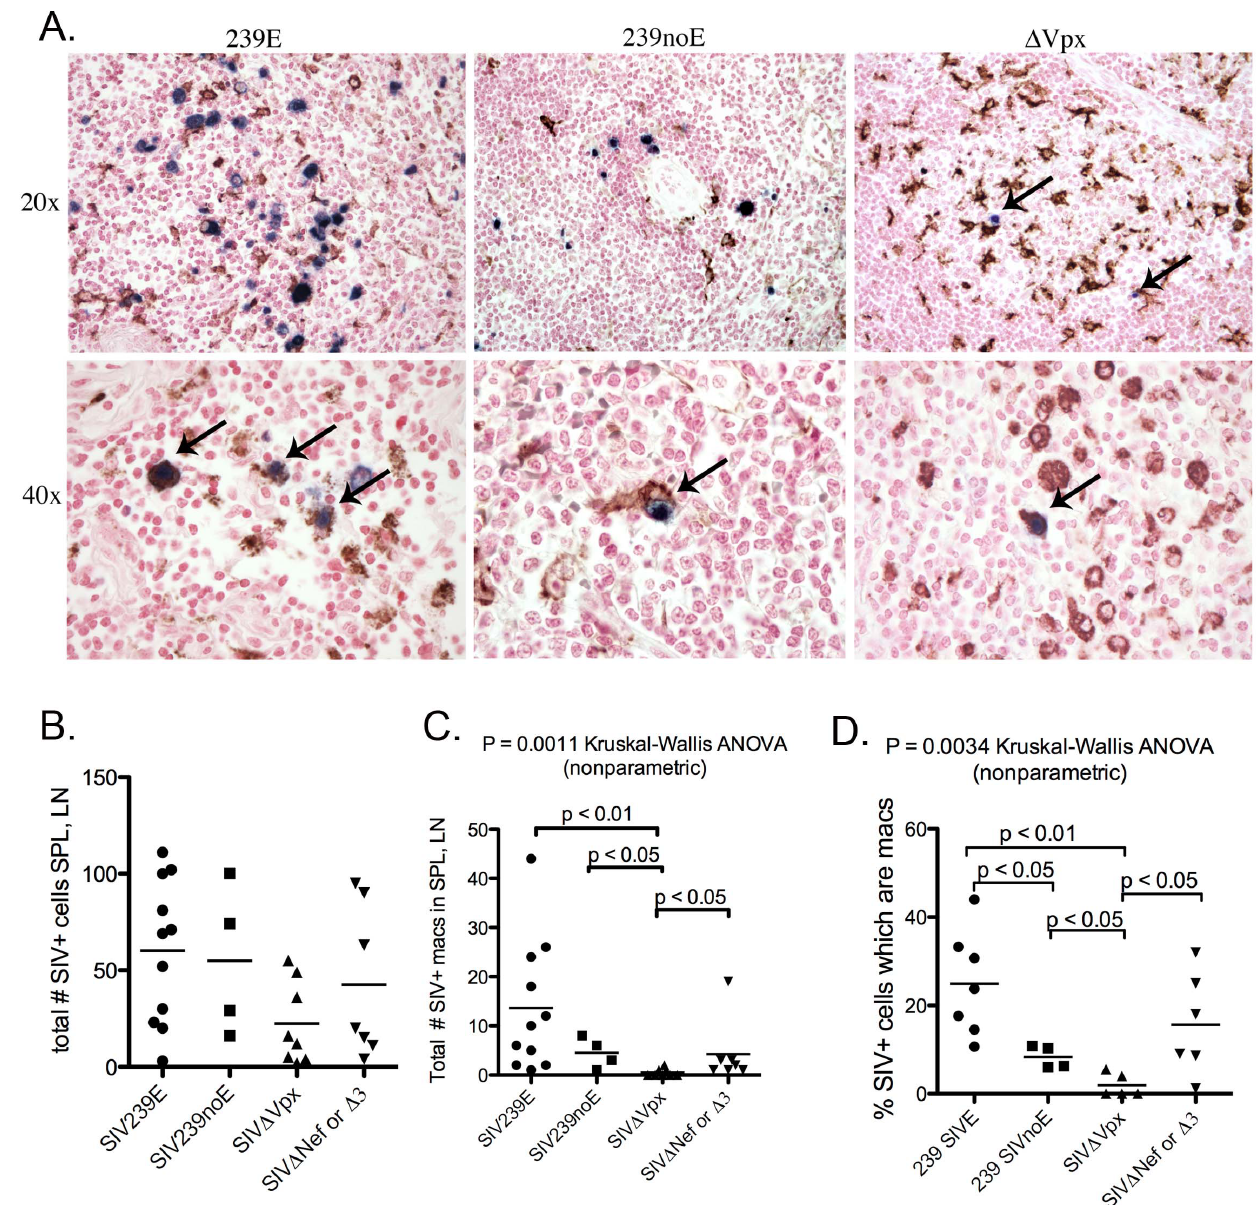
Figure 4. Double-label immunohistochemistry and insitu hybridization of lymphoid tissues. (A) Representative images of SIV in situ hybridization (ISH, blue) with double-label immunohistochemistry for monocyte/macrophage lineage cell marker Ham56 (DAB, brown) in rhesus macaques in groups SIV239E (left), SIV239noE (middle), and SIV D vpx (right). The top images of lymphoid follicles depict Ham-56 + cells morphologically consistent with follicular DCs. Images in the second row depict HAM56 + cells in the red pulp of the spleen (left and center) or paracortex in lymph node (right). Frequent SIV + HAM56 + macrophages/DCs (M w ) were observed in tissues from the SIV239E and SIV239noE groups, while only rare SIV + Ham56 + macrophages/DCs were observed in lymph node from a SIV D vpx -infected rhesus (arrow). (B). The overall numbers of infected cells in the spleen and lymph node from the 4 groups of animals were not significantly different. (C) However, there were significantly fewer SIV + M w in SIV D vpx monkeys (mean 0.5 SIV + M w ) compared to the SIV239E (mean 13.64 SIV + M w ), SIV239noE (mean 4.5 SIV + M w ) and SIV D nef /SIV D 3 monkeys (mean 6.25 SIV + M w ). (D) SIV infected macrophages made up a much lower percentage of all SIV + cells in SPL and LN of SIV D vpx -infected rhesus (mean 2.2%) compared to SIV239E (mean 22.7%), SIV239noE (mean 8.3%), and SIV D nef /SIV D 3 monkeys (10.1%) (p , 0.05). doi:10.1371/journal.pone.0084463.g004 tissue virus burden in SPL/LN and colon from the SIV D nef or